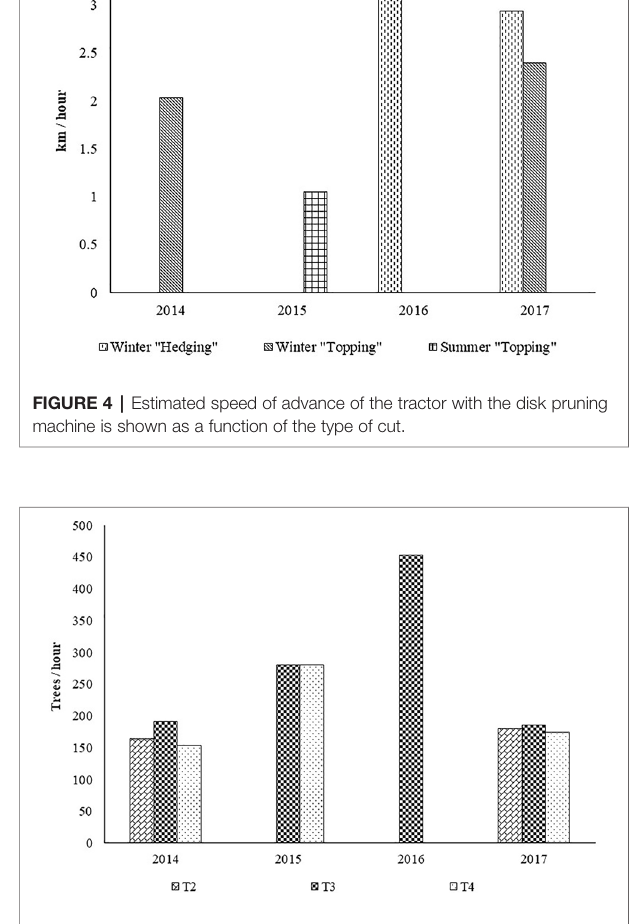
FIGURE 5 | Average work rates (trees/hour x man) by treatment with the disk saw pruning machine. Legend: T1, treatment 1; T2, treatment 2; T3, treatment 3; T4, treatment